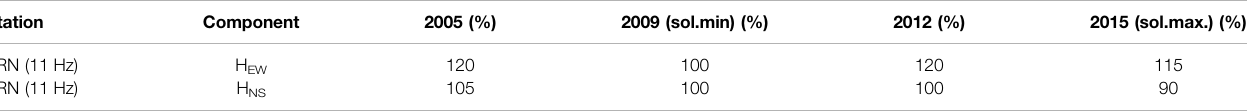
TABLE 2 | Normalized yearly averages of ELF intensity of 11 Hz at VRN for the years 2005, 2009, 2012, 2015.